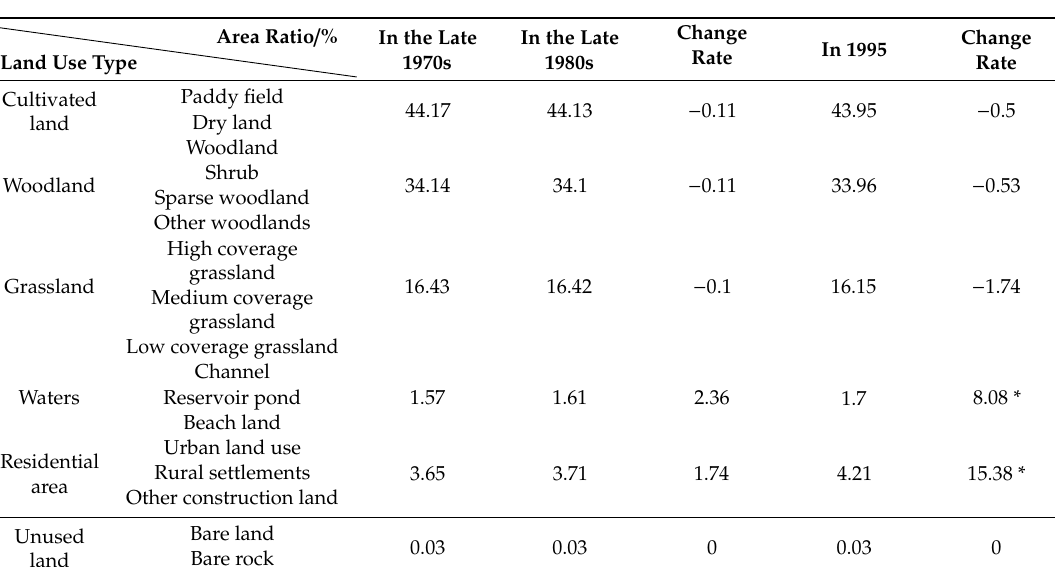
Figure 5. Spatial distribution of land use types in Yiluo River Basin in different periods. ( a ) In late 1997; ( b ) in the late 1980s; ( c ) in 1995; ( d ) legend. Table 3. Proportion and relative change rate with the end of 1970s of land use types in Yiluo River Basin in different periods.